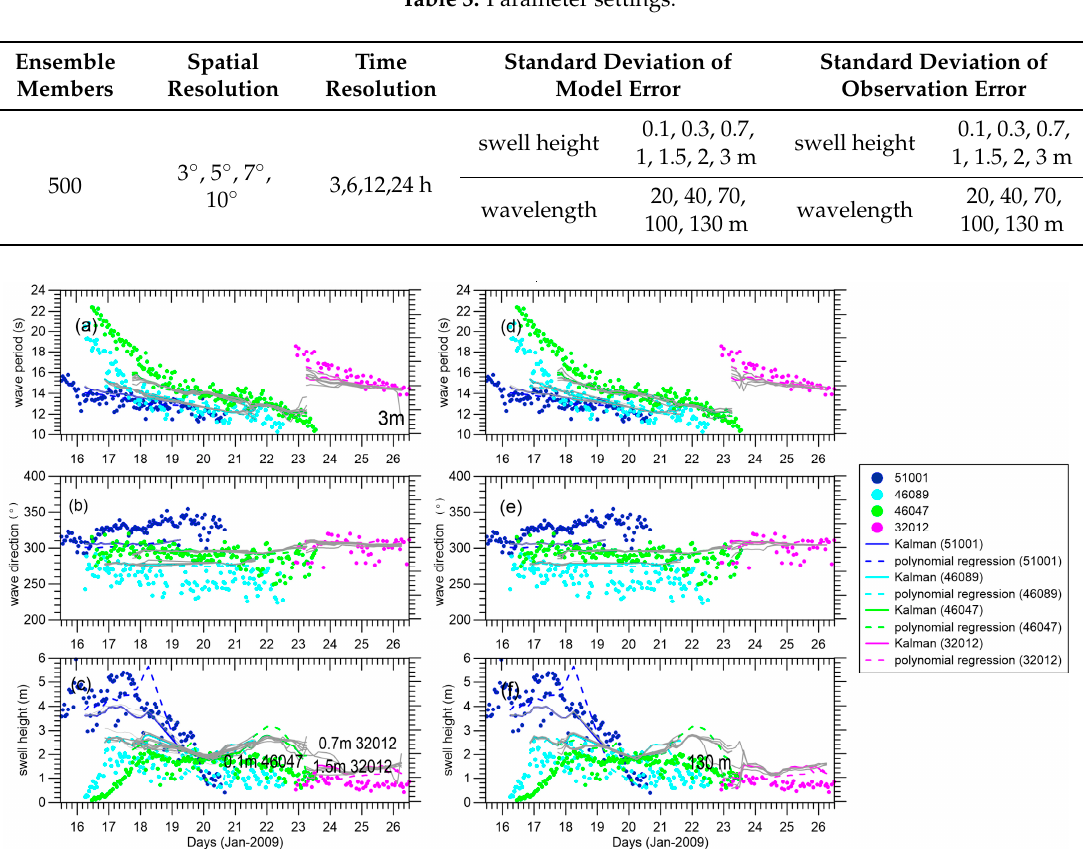
Table 3. Parameter settings.